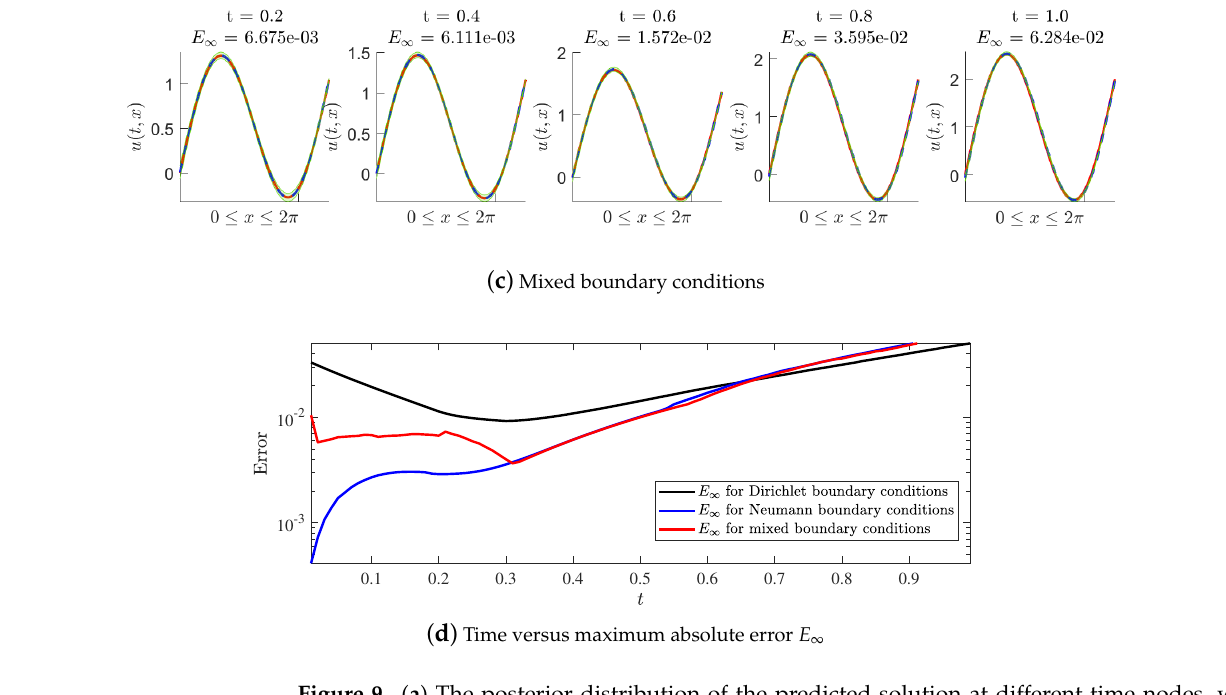
Figure 9. ( a ) The posterior distribution of the predicted solution at different time nodes, where Dirichlet boundary conditions are employed. ( b ) The posterior distribution of the predicted solution at different time nodes, where Neumann boundary conditions are employed. ( c ) The posterior distribution of the predicted solution at different time nodes, where mixed boundary conditions are employed. ( d ) Time versus the maximum absolute error E ∞ until the final time step is reached. Table 7. Example 5: Maximum absolute error E ∞ at some time nodes, where ∆ t = 0.01, where Dirichlet, Neumann and mixed boundary conditions are used,